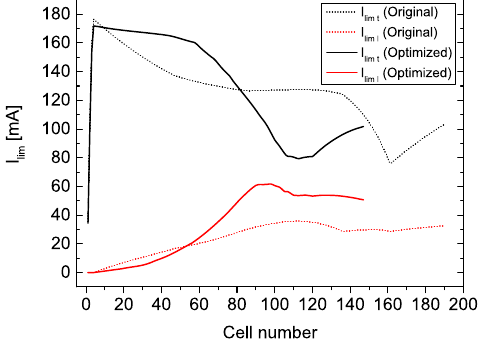
FIG. 4. Comparison of the transverse and longitudinal limiting current of the original and optimized designs.